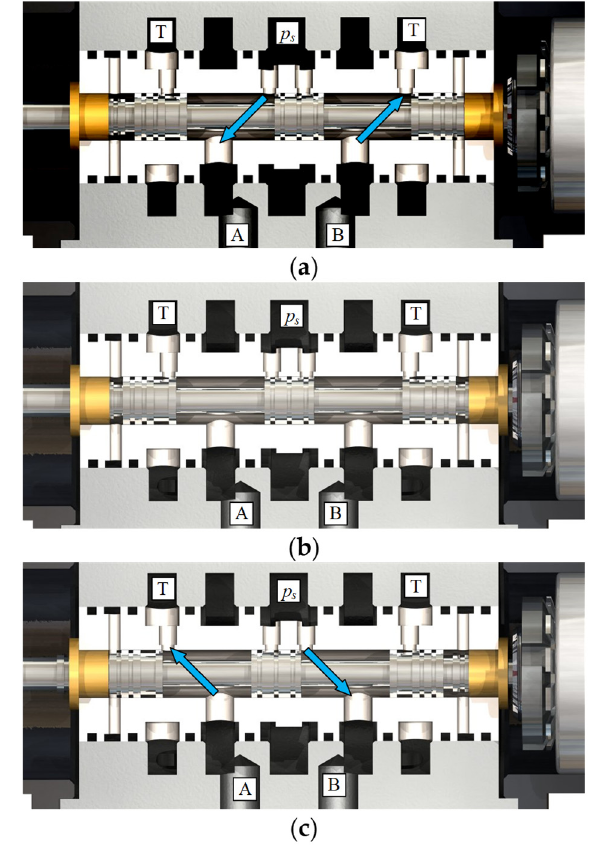
bearing (6) assembled to the valve housing. A ball screw of diameter 8 mm and lead of almost completely reduces the play. In the amplifier body, three rectangular gap windows piston (8); thus, the total valve gap length is equal to 6 mm, and the maximum single orifice area was 15 mm 2 .